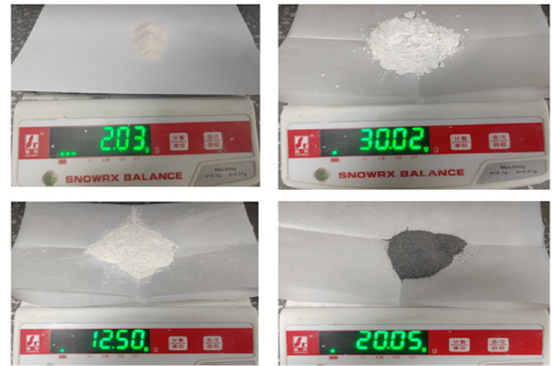
Figure 6. Weigh all types of mineral powders required.